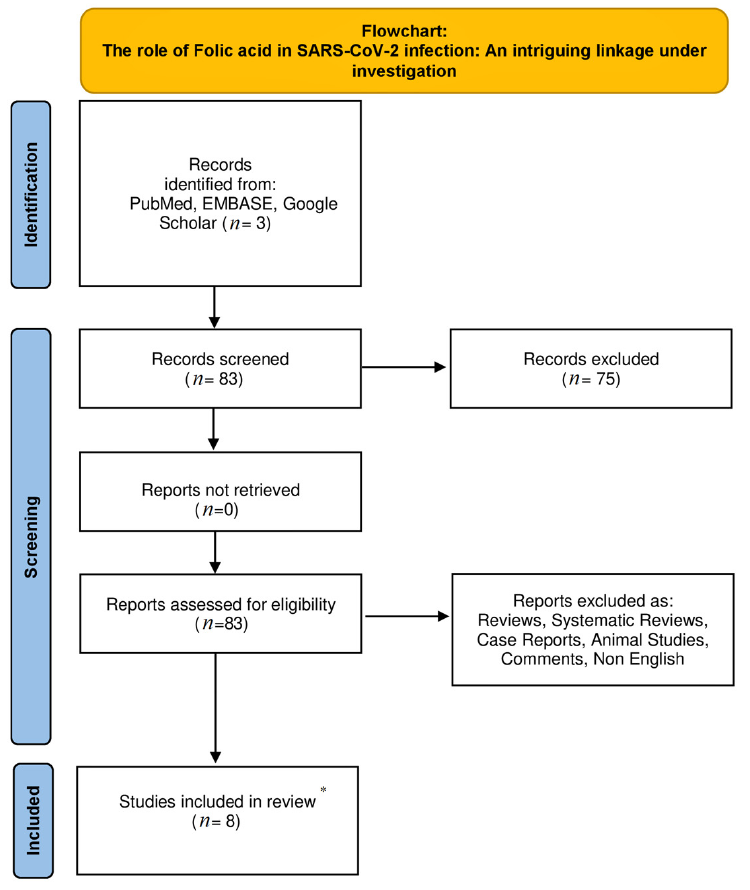
Figure 1. The flowchart of the study. * Only original non-animal studies written in English were included.